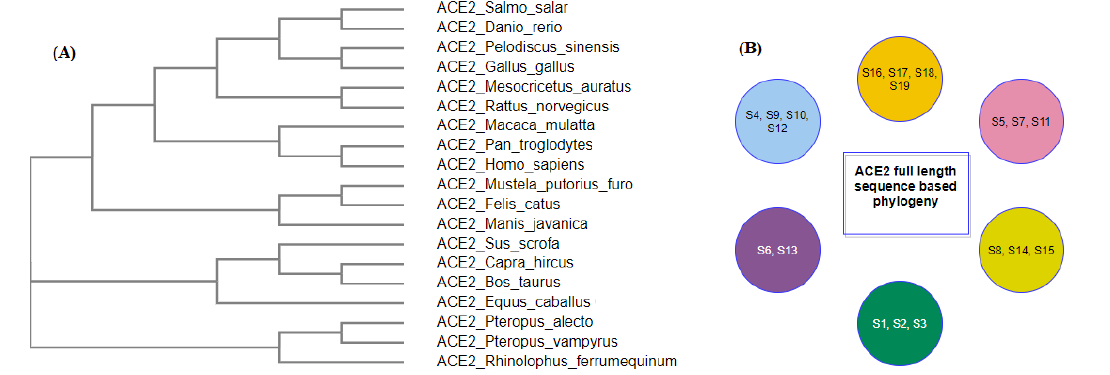
Figure 16. ACE2 full-length sequence-based phylogeny among nineteen species ( A ) and its derived clusters ( B ).